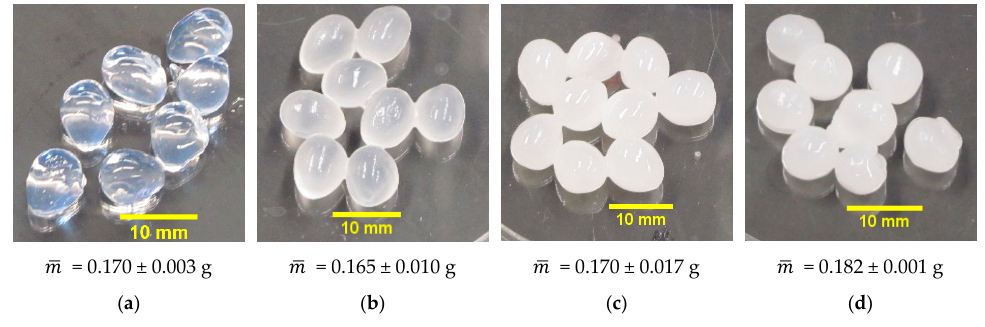
Figure 2. Images and the average mass per capsule, (cid:1865)(cid:3365) , of alginate capsules made from ( a ) pure alginate solution, ( b ) 20 wt% silicone oil-alginate emulsion, ( c ) 50 wt% silicone oil-alginate emulsion, ( d ) 60 wt% silicone oil-alginate